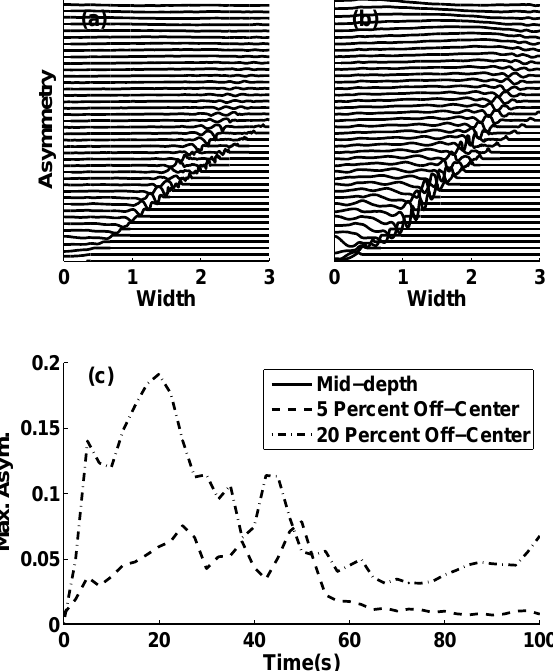
Fig. 8. Waterfall plot of the asymmetry in the tracer about the pyc- nocline for (a) − z 0 = H/ 2 + 0 . 05 H , and (b) − z 0 = H/ 2 + 0 . 20 H . (c) Plot of the maximum asymmetry versus